Question: What caption would you write for this figure?
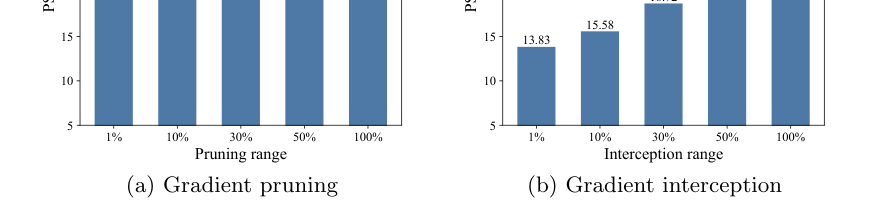
Answer: The impact of gradient pruning and gradient interception on GI-SMN. The horizontal axis indicates the retained gradient information (%).